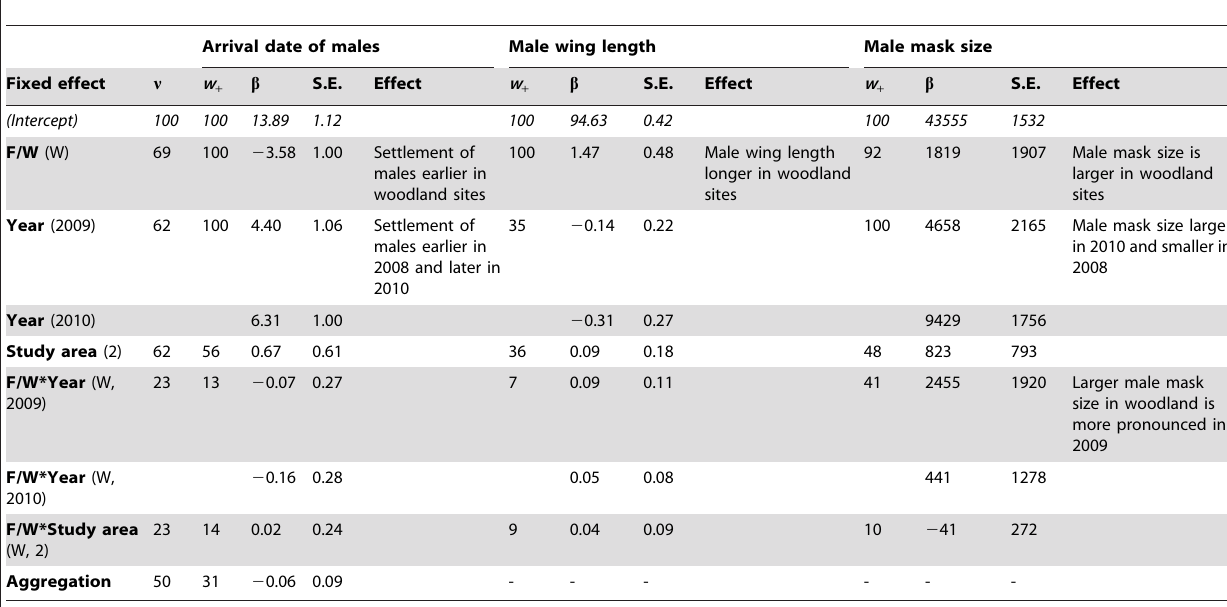
Table 2. Results of the AIC c -based multimodel inference procedure examining the variations in habitat preference relative to the independent variables.